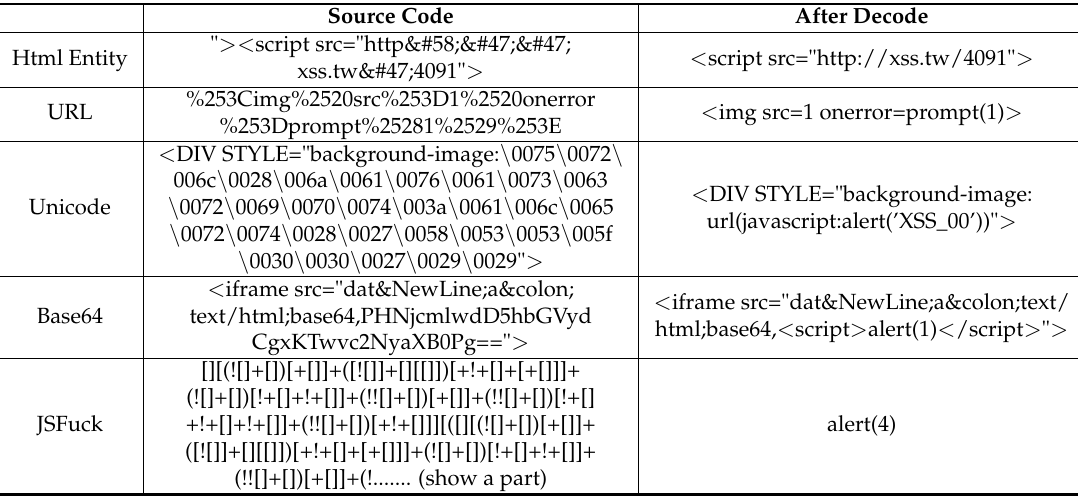
Table 3. Decoding Example for XSS